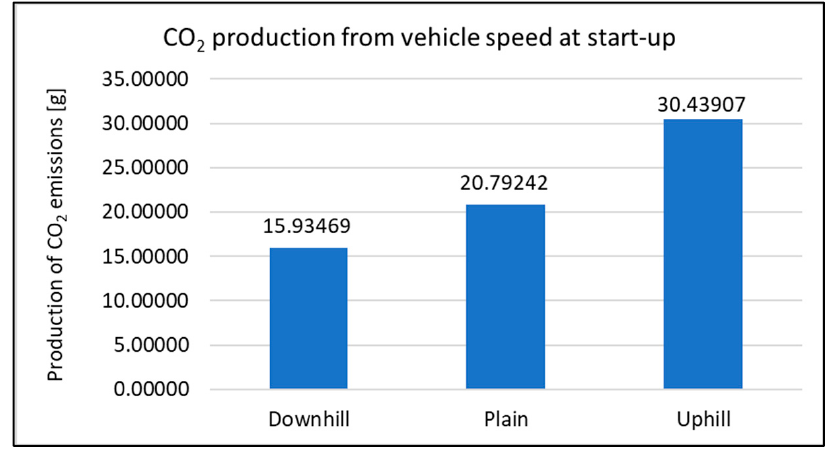
Figure 7. CO 2 production at start-up.